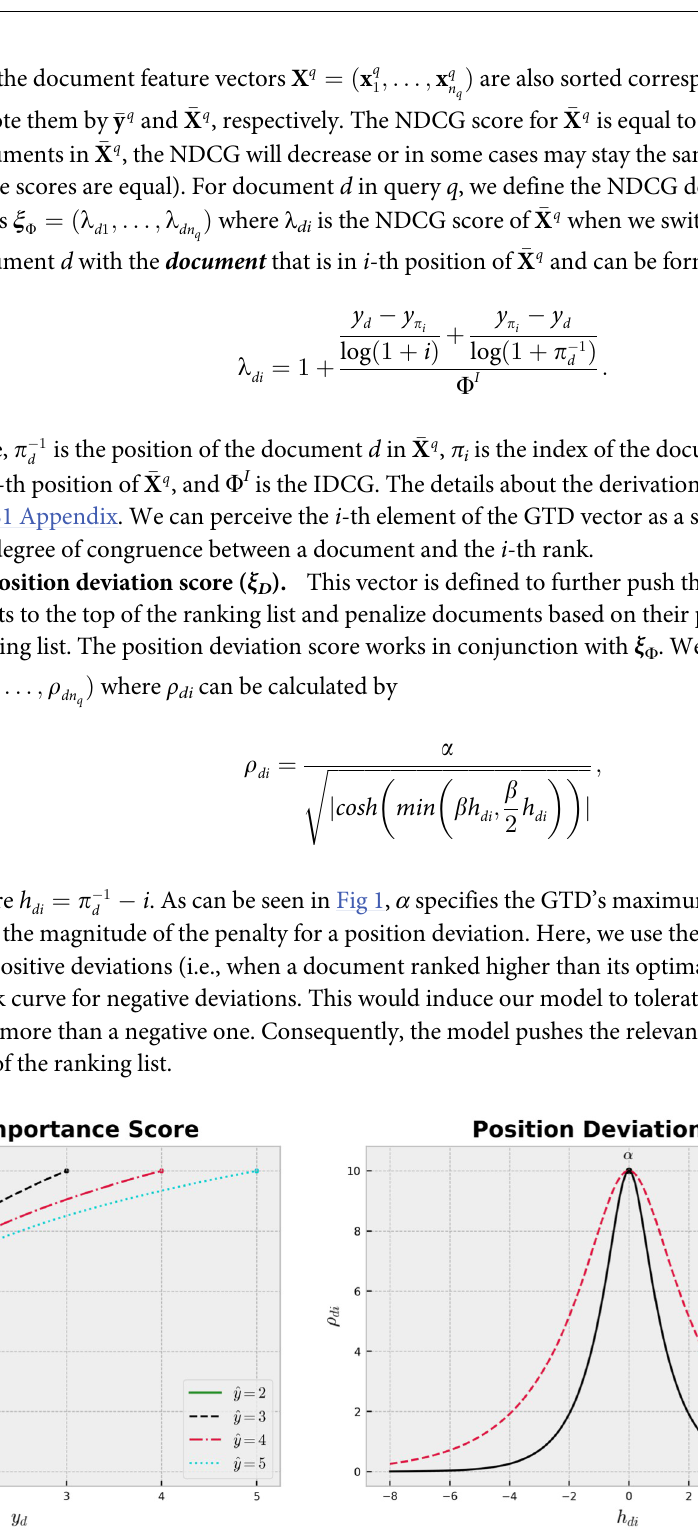
Fig 1. GTD graphs. (a) Position deviation score where α = 10 and β = 2. (b) Document importance score for various maximum possible relevance scores.